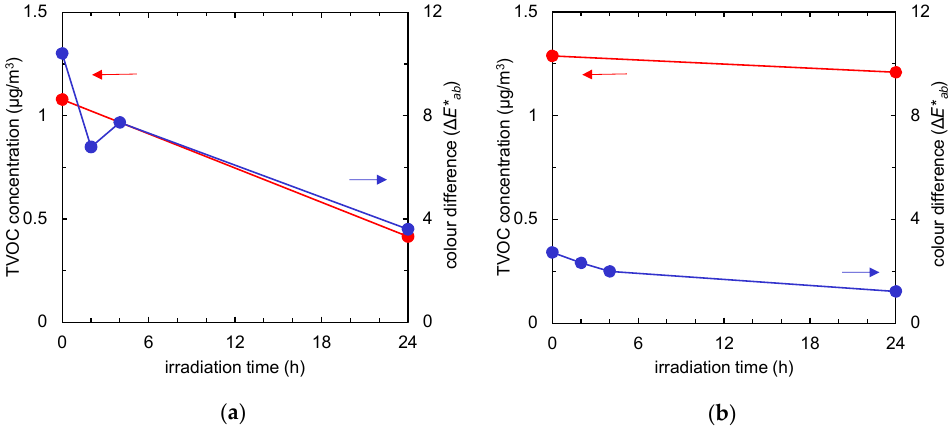
Figure 7. Time course of total volatile organic compound (TVOC) concentration (red) and the colour difference (the E * ab value compared to the colour of the fabric before tobacco smoke adsorption, shown by the blue line) of the fabrics after tobacco smoke adsorption vs. visible light irradiation time. ( a ) Non ‐ woven fabric with Fe/TiO 2 ; ( b ) non ‐ woven fabric without Fe/TiO 2 . Another type of visible ‐ light ‐ activated photocatalyst, Cu/WO 3 , showed different results, and Figures 8 and 9 report the behaviour of the non ‐ woven fabric samples embedded with this catalyst. Although the normalised GC ‐ MS chromatograms of the solid ‐ phase ‐ extracted odour components (Figure 8a) and the time course graphs of TVOC concentration (Figure 8b, red line) indicate that the odour components were decomposed, the colour did not revert to white after 24 h of irradiation (Figure 8b, blue line); instead, the colour of the fabric changed from yellow to dark yellow (Figure 9). ( a ) ( b ) Figure 8. ( a ) Gas chromatographs of solid ‐ phase ‐ extracted odour components at 0 h (black), and after 2 (blue), 4 (green), and 24 h (red) of visible light irradiation. ( b ) Time course of total volatile organic compound (TVOC) concentration (red) and the colour difference (the E * ab value compared to the colour of the fabric before tobacco smoke adsorption, blue) of the fabrics with Cu/WO 3 after tobacco smoke adsorption vs. visible light irradiation time.